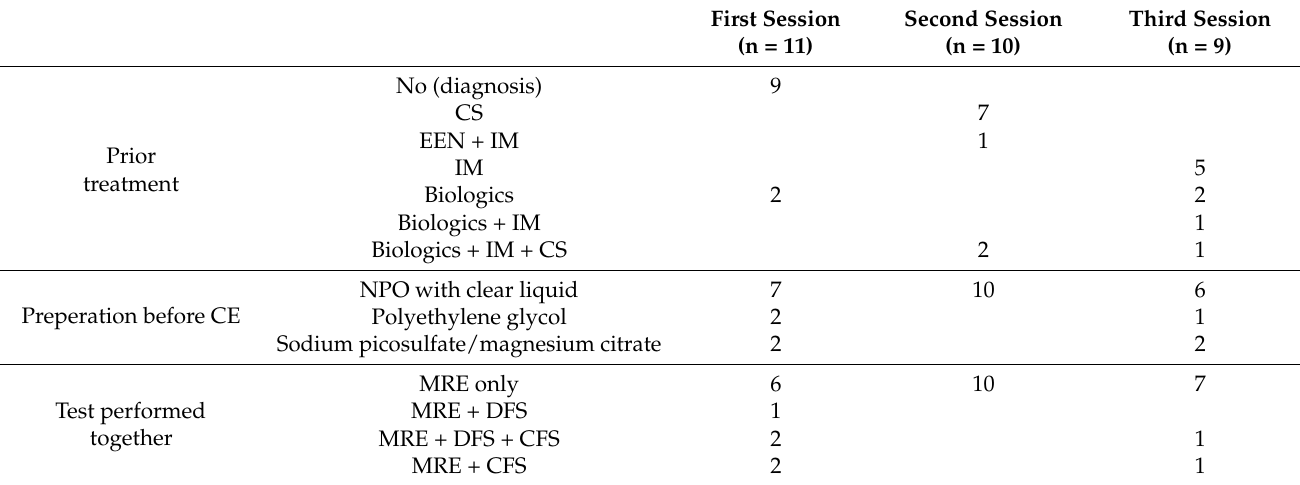
Table 1. Treatment of patients before each session, CE preperation and test performed together.